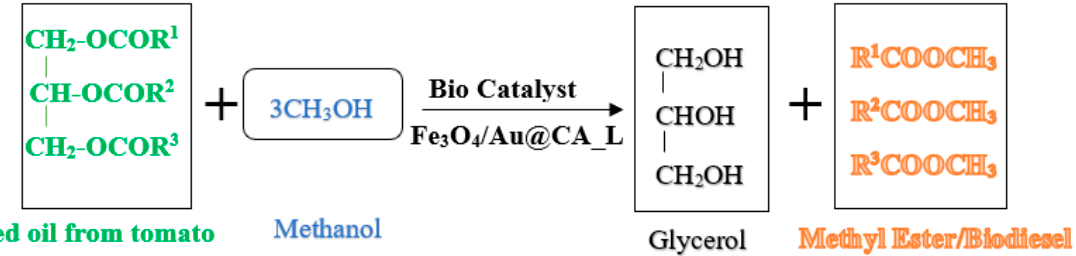
Figure 6. Transesterification reaction in tomato seed oils.